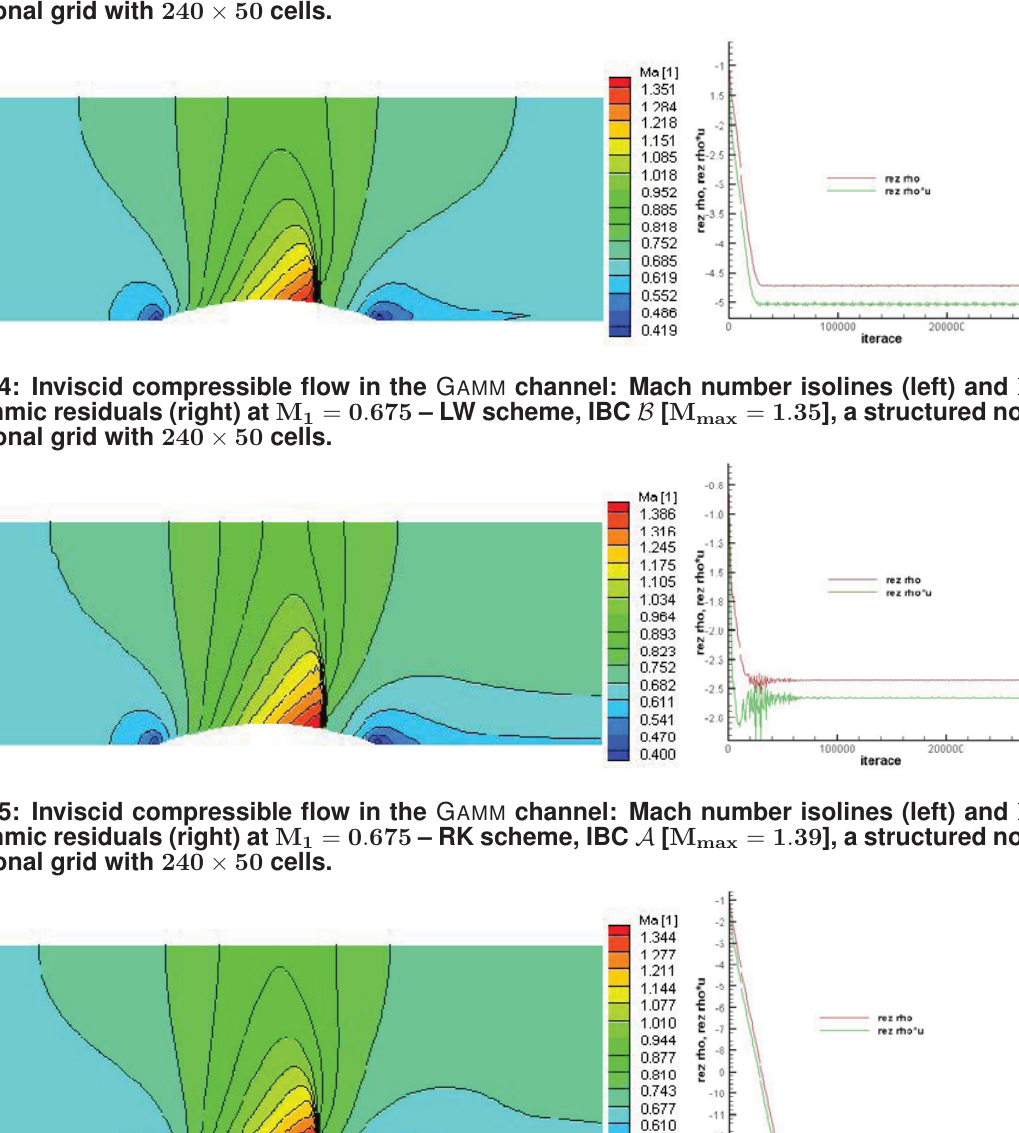
Figure 3: Inviscid compressible flow in the G AMM channel: Mach number isolines (left) and L 2 logarithmic residuals (right) at M 1 = 0 . 675 – LW scheme, IBC A [ M max = 1 . 42 ], a structured non- orthogonal grid with 240 × 50 cells.